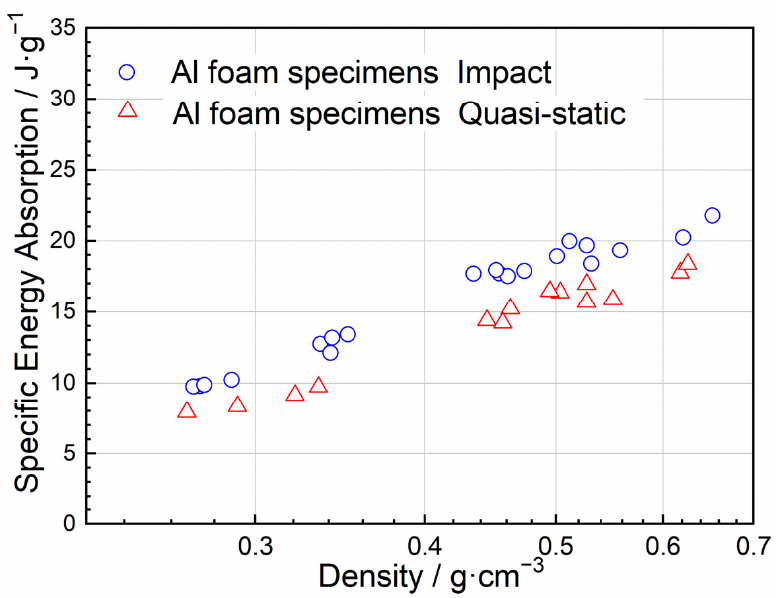
Figure 13. Comparison of dynamic specific energy absorption with that of quasi-static.